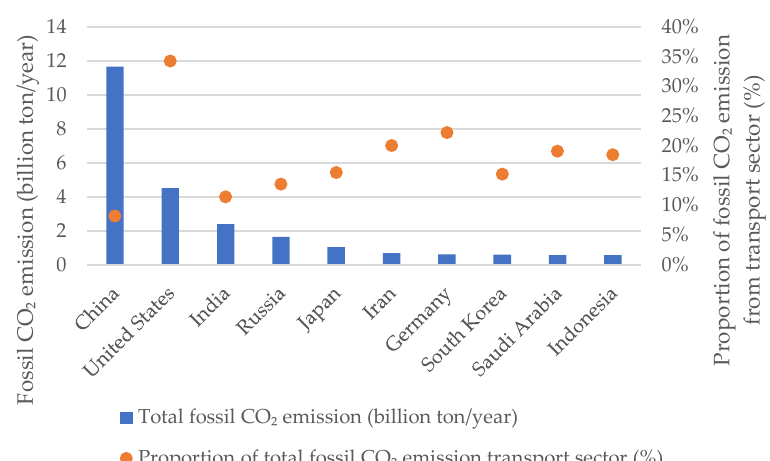
Figure 1. Total CO 2 emission from the largest 10 emitters and the proportion of CO 2 emission from the transport sector in 2020. Data source: EDGARv6.0 FT2020 fossil CO 2 GHG booklet2021. https://edgar.jrc.ec.europa.eu/report_2021#emissions_table (accessed on 19 December 2021).